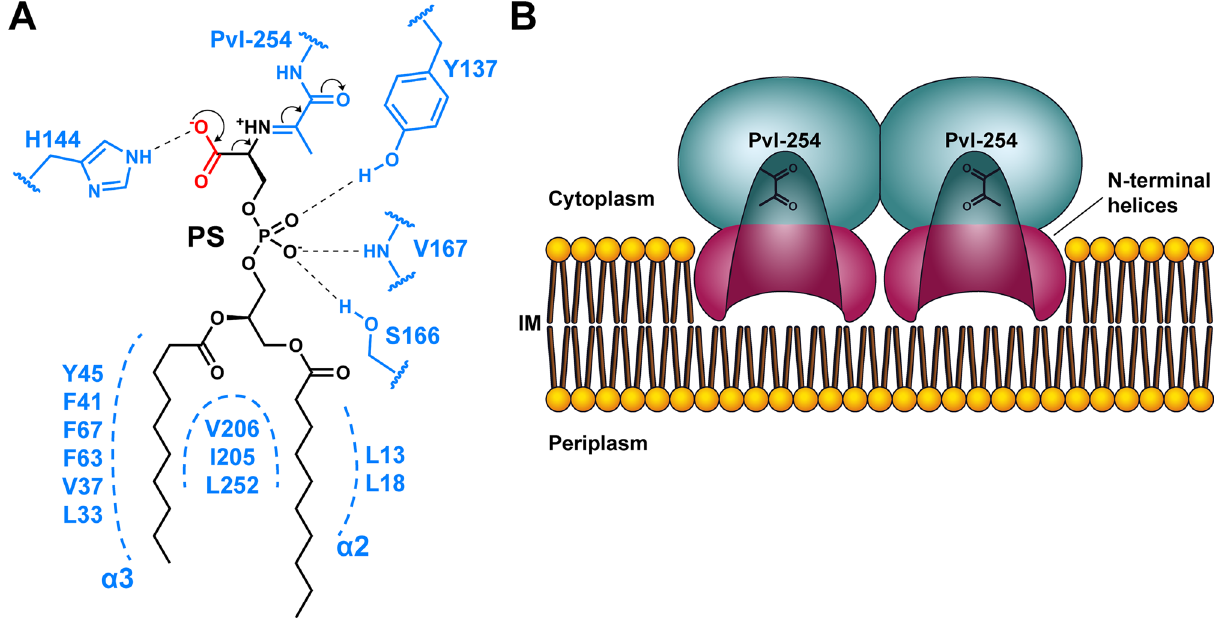
Figure 7. Proposed mechanism of PS decarboxylation and membrane association. ( A ) A scheme of decarboxylation after the formation of a Schiff base intermediate. A 10:0/10:0 acyl-chain of PS is depicted as a representative. Protein residues surrounding the substrate are colored in light blue and carboxylate of PS in red. ( B ) A model of membrane association of E. coli PSD, where core domains of PSD αβ-heterodimer are colored in cyan, and N-terminal helices in magenta. Pyruvoyl residues of the active site on each molecule are denoted as black stick. Inner membrane (IM) is shown in orange and